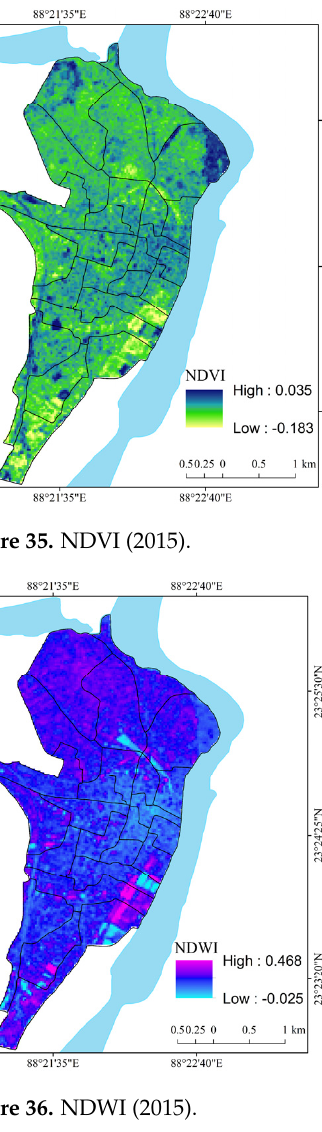
Figure 36. NDWI (2015).